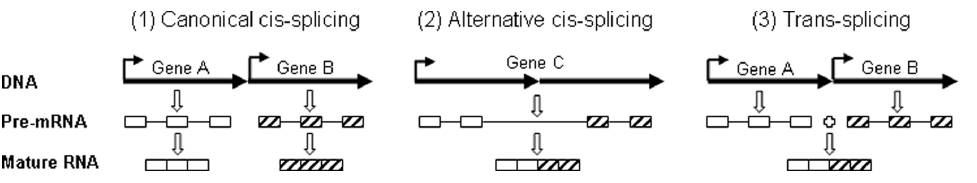
Figure 1. Our definition of cis- and trans-splicing in the situation of transcripts from two tandem genes on the same chromosome. ( 1 ): Two (A and B) tandem genes are transcribed separately as different pre-mRNA molecules, and each pre-mRNA is spliced independently to produce a mature RNA. This is canonical cis-splicing. ( 2 ): Transcription of gene A reads through the termination signal, due to whatever reason, and enters into gene B, resulting in a single, long pre-mRNA that can be regarded as: a) a transcript of a different gene (gene C), b) an alternatively terminated pre-mRNA of gene A, or c) an alternatively initiated transcript of gene B. This long pre-mRNA may be spliced to a different mRNA, such as one lacking the last exon of gene A and the first exon of gene B. We define this type of splicing of an alternatively transcribed pre-mRNA as an alternative cis-splicing. ( 3 ): Genes A and B are transcribed separately, and the two pre-mRNAs are spliced into one mature mRNA. We define this situation, if it happens, as trans-splicing. Hence, trans-splicing is a biochemical reaction involving two RNA transcripts as the substrate molecules, no matter whether they are transcribed from tandem genes on the same chromosome, from both Watson and Crick strands of the same genomic locus with a sense-and-antisense relationship, or from different chromosomes as two unrelated